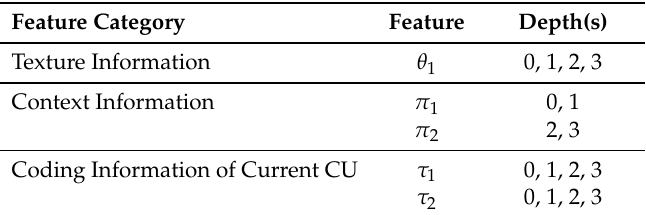
Table 2. Features used for different CU depth levels in Stage